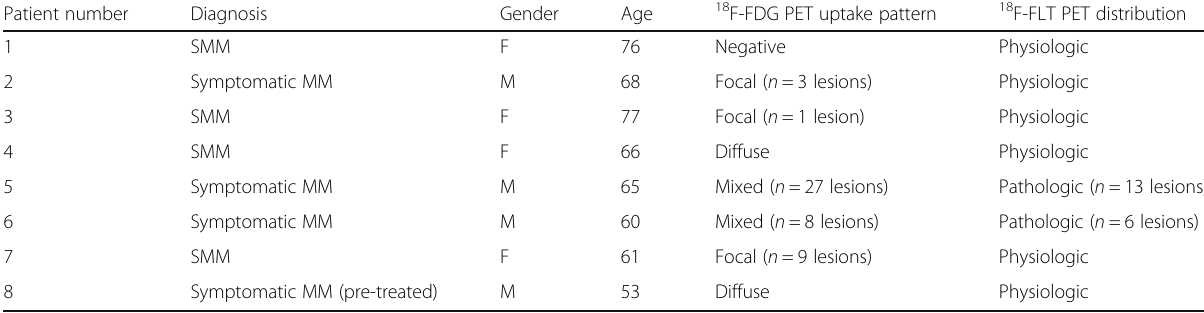
Table 1 Characteristics of the patients enrolled in the study Patient